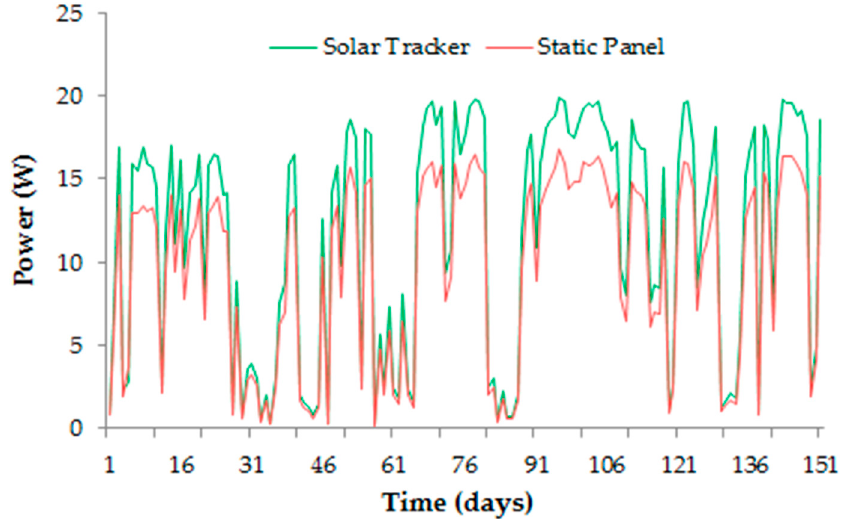
Figure 11. Average daily production obtained by the solar tracker.